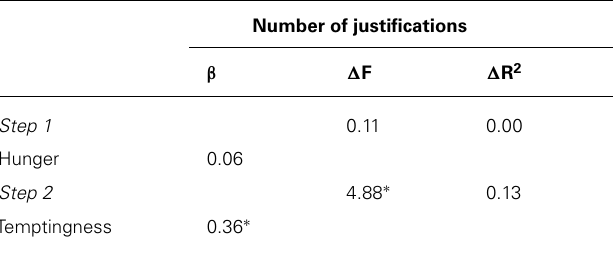
Table 4 | Hierarchical multiple regression analysis for number of self-generated justifications (Study